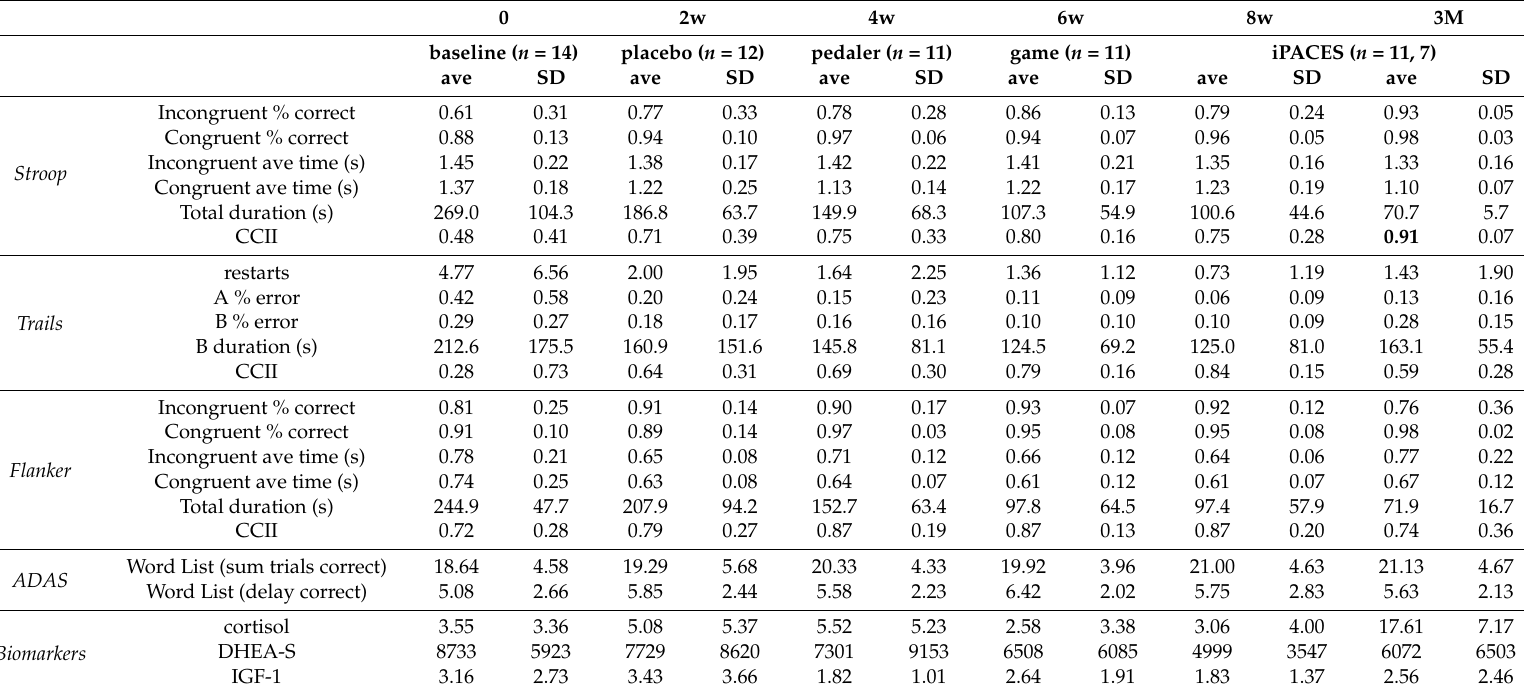
Table 1. Cognitive and biomarker data. Note: bold indicates p < .05 (ITT: n = 7, and ITT imputed: n = 14) compared both with baseline and end of component familiarization (end of